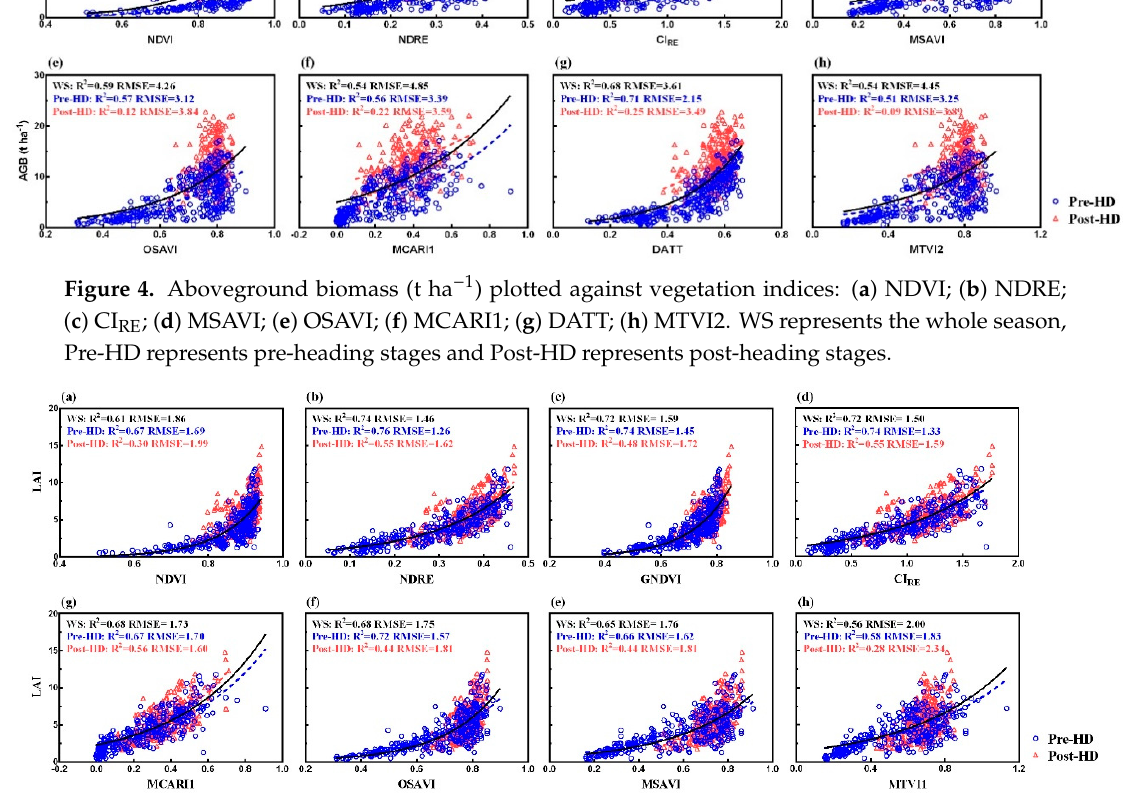
Figure 4. Aboveground biomass (t ha − 1 ) plotted against vegetation indices: ( a ) NDVI; ( b ) NDRE; ( c ) CI RE ; ( d ) MSAVI; ( e ) OSAVI; ( f ) MCARI1; ( g ) DATT; ( h ) MTVI2. WS represents the whole season, Pre- HD represents pre-heading stages and Post-HD represents post-heading stages.